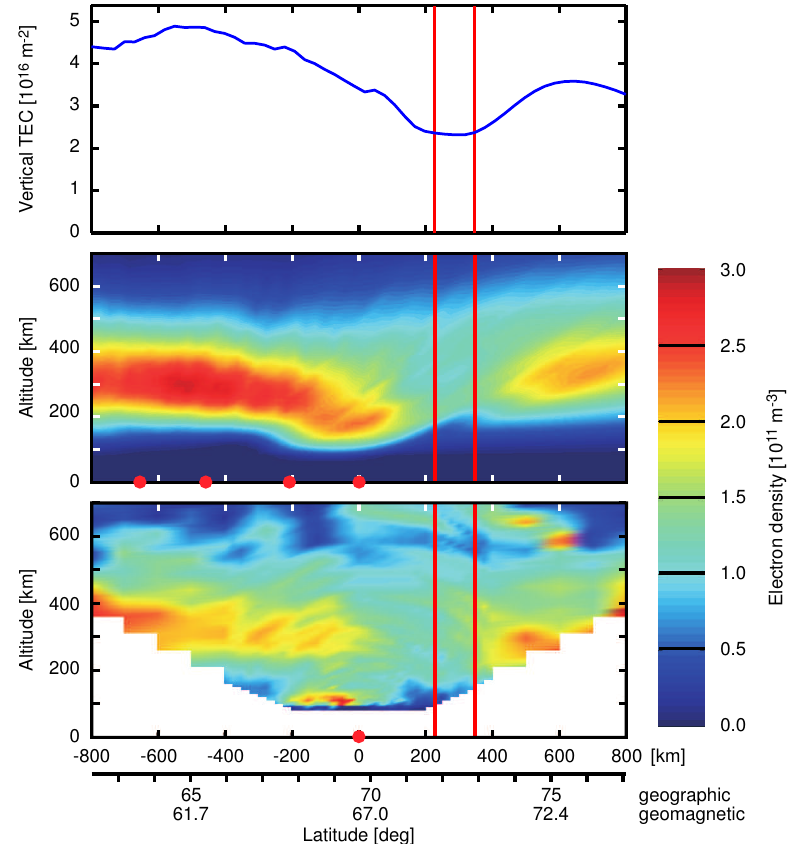
Fig. 1. Example of a trough observation by means of satellite tomography (middle panel) and the EISCAT UHF incoherent scatter radar (bottom panel). The top panel shows the vertical TEC between 200 km and 400 km; the edges are marked with lines. The observations are from June 25, 2003 at about 0100 UT. The red dots indicate the positions of the satellite receivers and the EISCAT UHF radar.